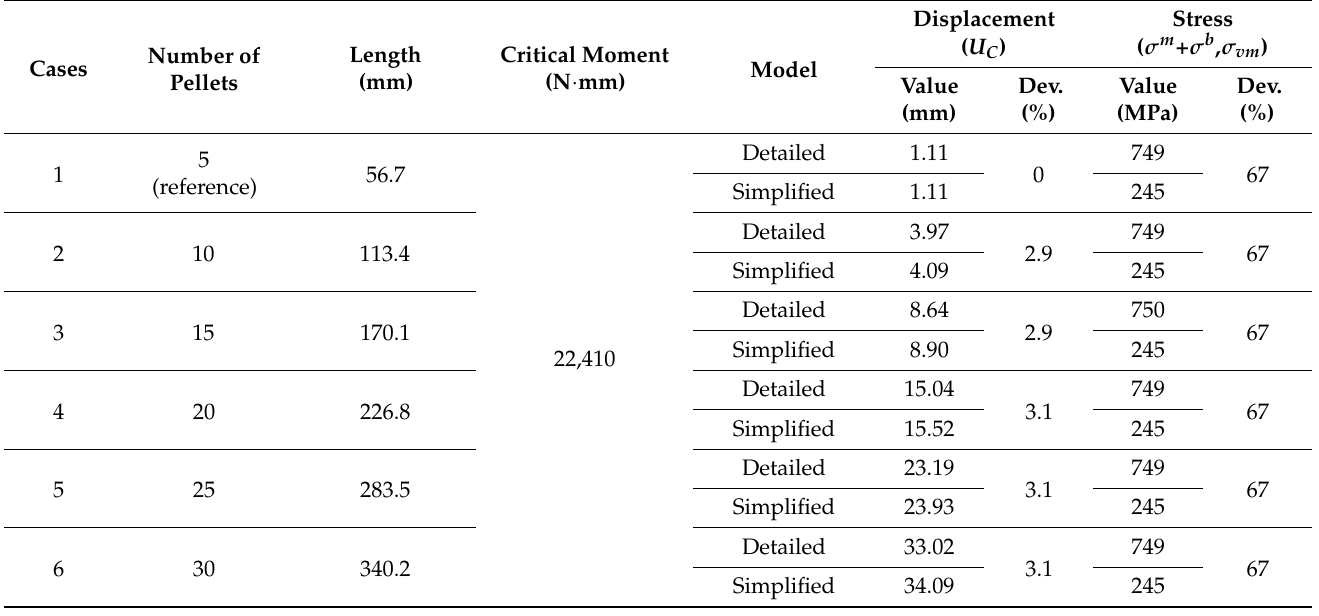
Table 6. Application of the simplified model parameters for the de-bonded condition to different lengths of fuel rod segments.